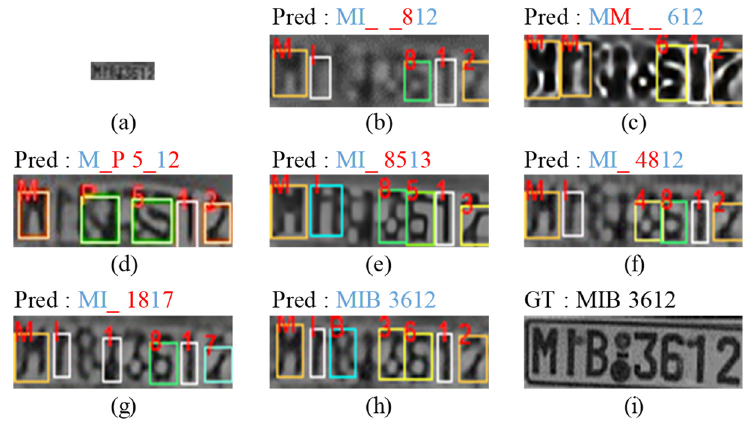
Figure 12. LP recognition results on the Greek vehicle dataset with ( a ) input low-quality legacy image (28 × 8), ( b ) bicubic result (112 × 32), ( c ) MZSR result, ( d ) DRN result, ( e ) SwinIR result, ( f ) HIFA-LPR (Step 1) result, ( g ) HIFA-LPR (Step 2) result, ( h ) HIFA-LPR (Step 3) result. ( i ) HR image. “_” denotes a missing character. Red character denotes an incorrect prediction. Blue character denotes a correct prediction. “GT” denotes ground truth. “Pred” denotes the prediction result.